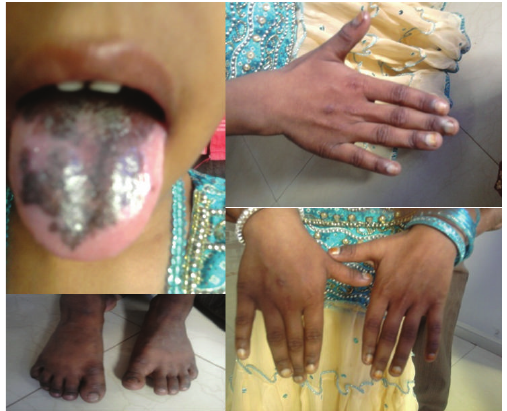
Figure 1: Case 1—clinical picture showing oral leukoplakia, nail dystrophy, and hyperkeratotic pigmented patches on hands and feet.